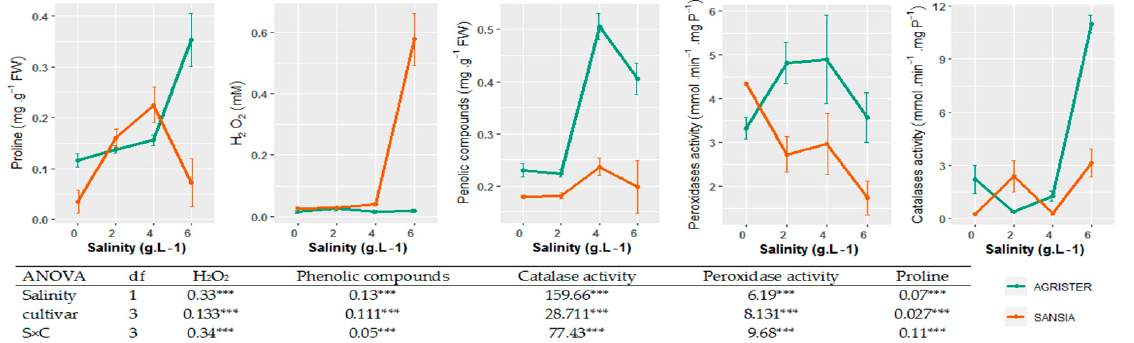
Figure 1. The effect of salt stress (0, 2, 4, and 6 g ∙ NaCl L − 1 ) on proline, H 2 O 2 , phenolic compounds, and peroxidase and catalase activities. The sum square values with statistical significance are shown (ns: non ‐ significant, ***: p < 0.001).